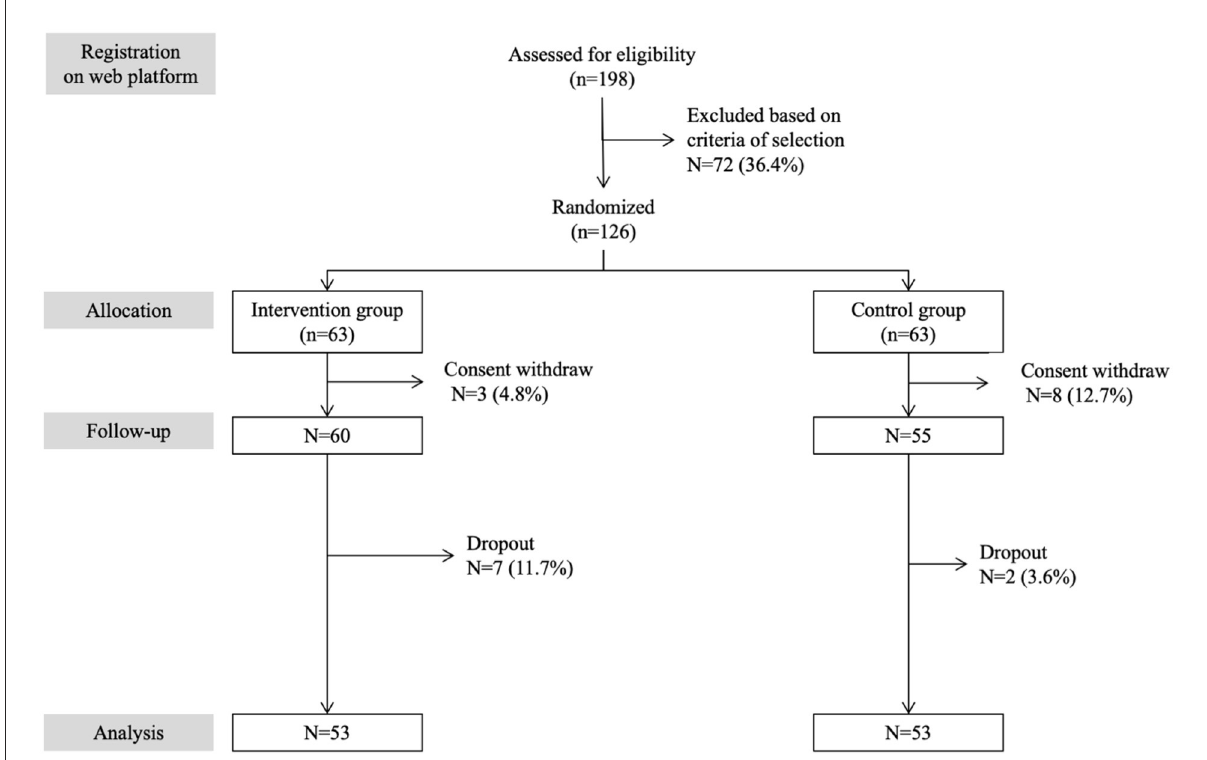
FIGURE1 Consort flow diagram detailing selection and follow-up of participants in the